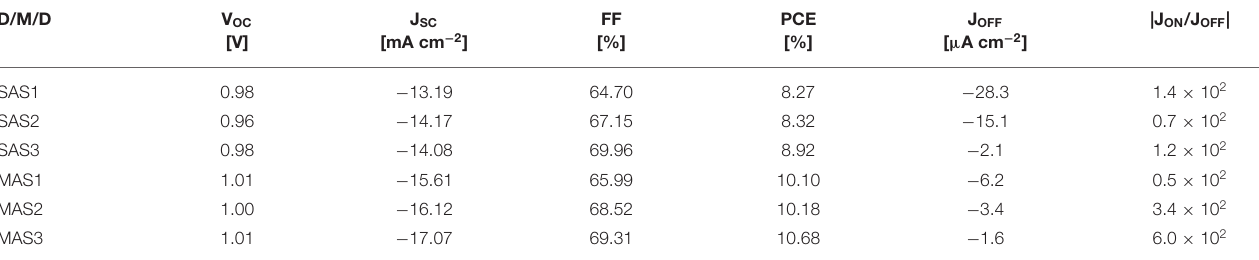
TABLE 2 | Open circuit voltage (V OC ), short circuit current (J SC ), fill factor (FF), and power conversion efficiency (PCE) of the best perovskite solar cells fabricated on glass/SnO 2 /Au/SnO 2 (SAS) and glass/MoO x /Au/SnO 2 (MAS) dielectric/metal/dielectric (D/M/D) electrodes with different thickness of the SnO 2 top layer, achieved by repeating the spin-coating process once (SAS1, MAS1), twice (SAS2, MAS2), or three times (SAS3, MAS3).